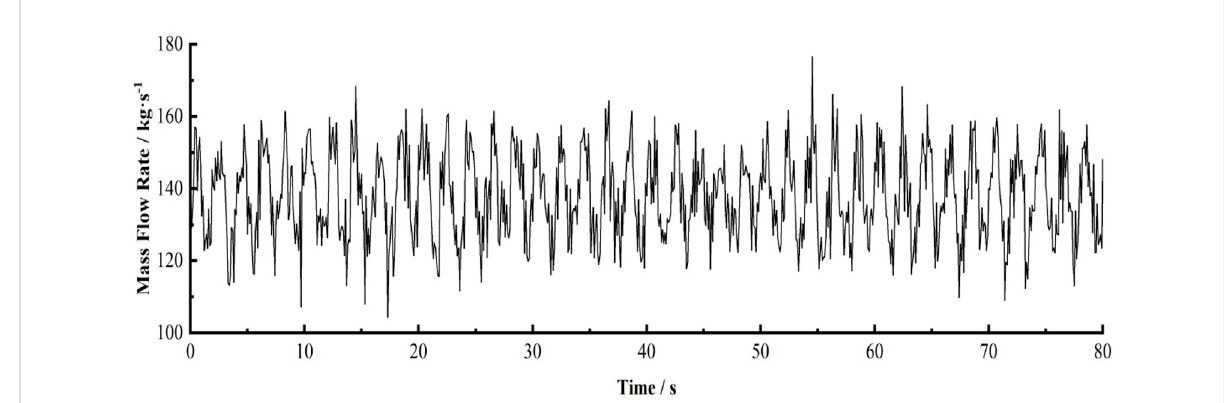
FIGURE 7 Variation in the core inlet fl ow.